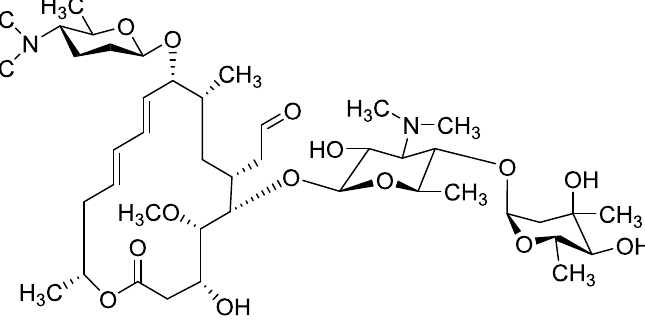
Figure 1: Chemical structure of Spiramycin structure.